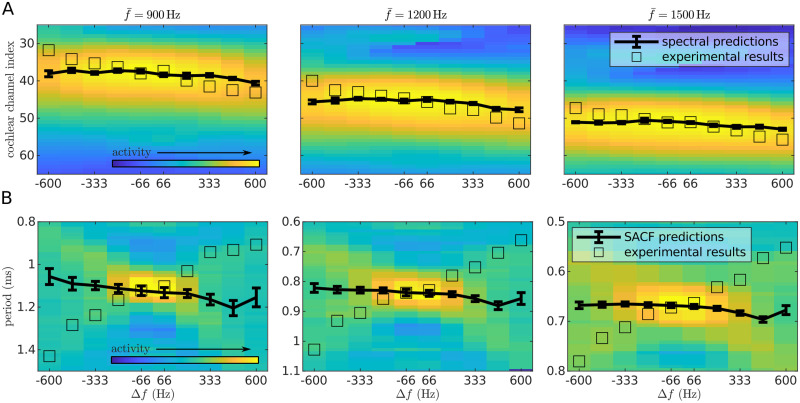
Predictions of the bottom-up models of pitch.A) Predictions of the spectral model. Heatmaps show the mean activation across the duration of the stimuli at different cochlear channels, as simulated by a model of the auditory periphery in response to each sweep; units are arbitrary. Error bars point to the expected value and standard deviation of the distribution across frequencies for each sweep. Each empty square denotes the expected channel elicited by a pure tone with the frequency of the average experimental data of the corresponding sweep. B) Predictions of the temporal model. Heatmaps show the distribution across periods elicited in the summary autocorrelation factor (SACF) for each sweep. The value corresponding to each period was computed as the average activation of the SACF across four harmonics (see Methods); heatmap units are arbitrary. Error bars point to the expected value and standard deviation of the distribution across periods for each sweep. Each empty square denotes the expected period elicited in the SACF by a pure tone with the frequency of the average experimental data of the corresponding sweep.